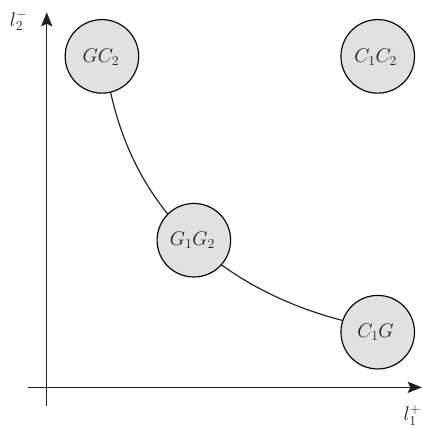
Figure 7: The relation between the relevant momentum regions for diagrams (i) and (ii). The line connecting the circles represents a surface of constant